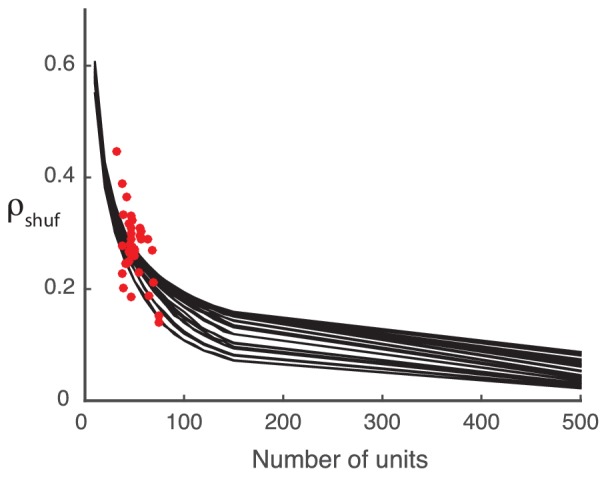
Detected structure in randomly generated covariance matrices is a finite-size effect.The model performance (ρshuf) decreases with increasing system size (black curves). The ρshuf computed from the shuffled neural data (red dots) falls in the same area as the synthetic data performance, suggesting that the synthetic data is a reasonable stand-in.